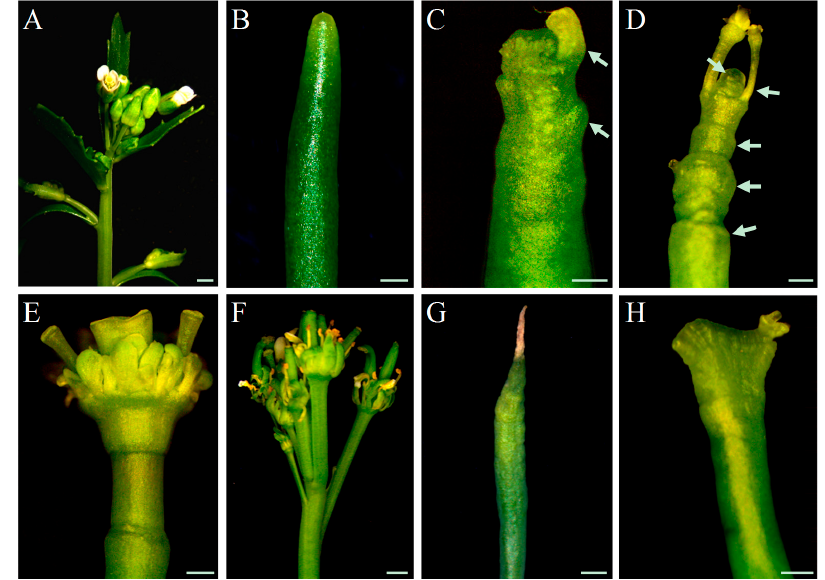
Figure 1. The phenotype of inflorescence shoots. The phenotype of the stem apex of wild-type (WT) ( A ) and pin1 mutant ( B – H ) Arabidopsis plants. pin1 mutant stems showing several developmental features of its apex: without organs ( B ); with single bulges and developing organ primordia ( C ), denoted with arrows; with numerous bulges, folds and malformed organs ( D ), denoted with arrows; a termination with a single organ ( E ), multiple organs ( F ), and meristem necrosis ( G ); fasciation ( H ). Scale bar 200 µ